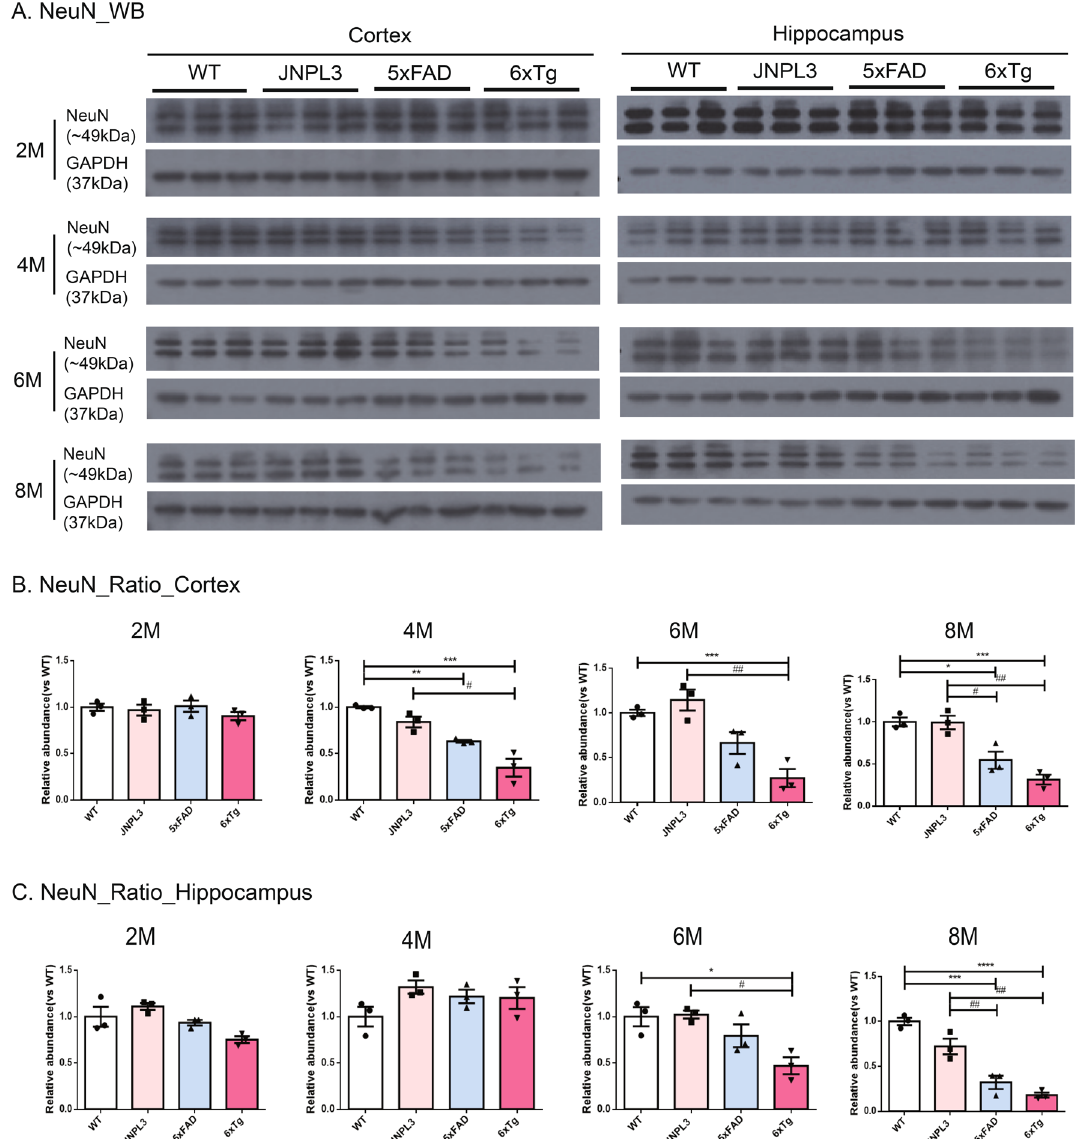
Figure 6. Neuronal cell levels in the cortical and hippocampal area of the 6xTg brain. Neuronal cells (NeuN, 46~48 kDa) were detected in cortical and hippocampal tissue lysates of 2-, 4-, 6-, and 8-month-old WT, JNPL3, 5xFAD, and 6xTg mice by Western blot analysis. ( A ) Representative Western blots of NeuN from cortical and hippocampal brain lysates. In Fig. S5, full-length blots were presented. ( B ) The graph shows the percentage of the density of NeuN normalized to GAPDH on Western blot bands from cortical and hippocampal tissue lysates. B) In the cortex, 4-, 6- and 8-month-old 6xTg mice showed significantly decreased NeuN compared with 5xFAD and WT mice. ( C ) In the hippocampus, 6- and 8-month-old 6xTg mice showed significantly decreased NeuN compared with 5xFAD and WT mice. All data are shown as means ± SEM, and each experiment was repeated five times (n = 3 per group). Statistical analyses were performed by one-way ANOVA by the Tukey’s multiple comparisons test. **** p < 0.0001, *** p < 0.001, ** p < 0.01 vs. WT; #### p < 0.0001, ### p < 0.001, ## p < 0.01 vs. JNPL3; $$$$ p < 0.0001, $$$ p < 0.001 vs. significantly reduced in both the cortex and hippocampus of 5xFAD (Fig. 5B,C). However, in the cortex of 4-months-old 6xTg mice, the synaptophysin amount was significantly decreased relative to age-matched WT, JNPL3, or 5xFAD mice (6xTg ratio vs WT; 0.47 ± 0.02, p < 0.001 vs. WT, p < 0.001 vs. JNPL3, p < 0.01 vs. 5xFAD) (Fig. 5B). At 6 months of age, the quantity of synaptophysin was significantly decreased in both the cortex and hippocampus of the 6xTg mice compared to WT, JNPL3, and 5xFAD mice (cortex: 0.46 ± 0.02, p < 0.001 vs. WT, p < 0.05 vs. JNPL3; hippocampus: 0.60 ± 0.06, p < 0.01 vs. WT, p < 0.05 vs. JNPL3 , p < 0.01 vs. 5xFAD) (Fig. 5B,C). Next, we screened the neuronal loss in 2-, 4-, 6-, and 8-month-old WT, 5xFAD, and 6xTg mice. This is because the marked synaptic loss in the brains of 6xTg mice has been identified from 4 months of age, which was earlier than expected. At 2 months of age, neuronal loss was undetectable in all groups of mice (Fig. 6A). In